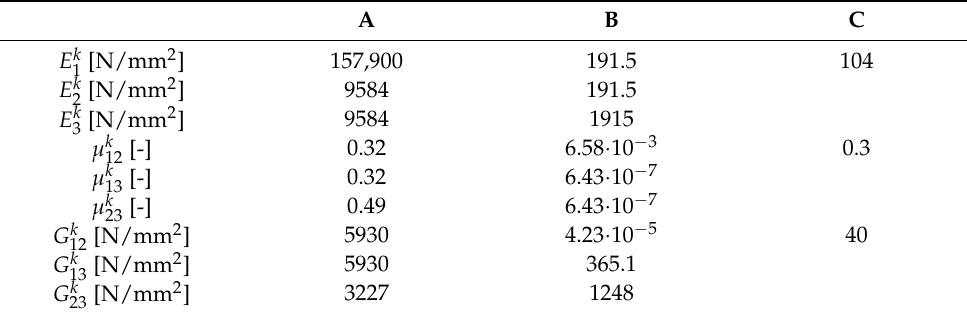
Table 2. Example 2: Properties of the materials in the plate.